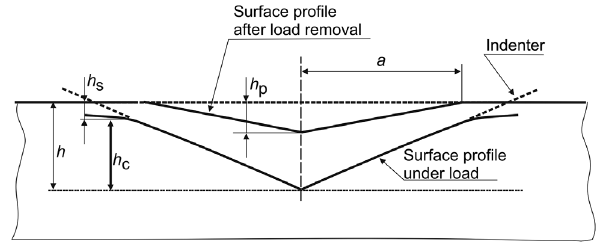
Figure 12: The outline of the deformations in the material during the penetrator pressing, h – maximum depth; h p – permanent indentation depth, h c – contact depth of the indenter with the sample at F max .